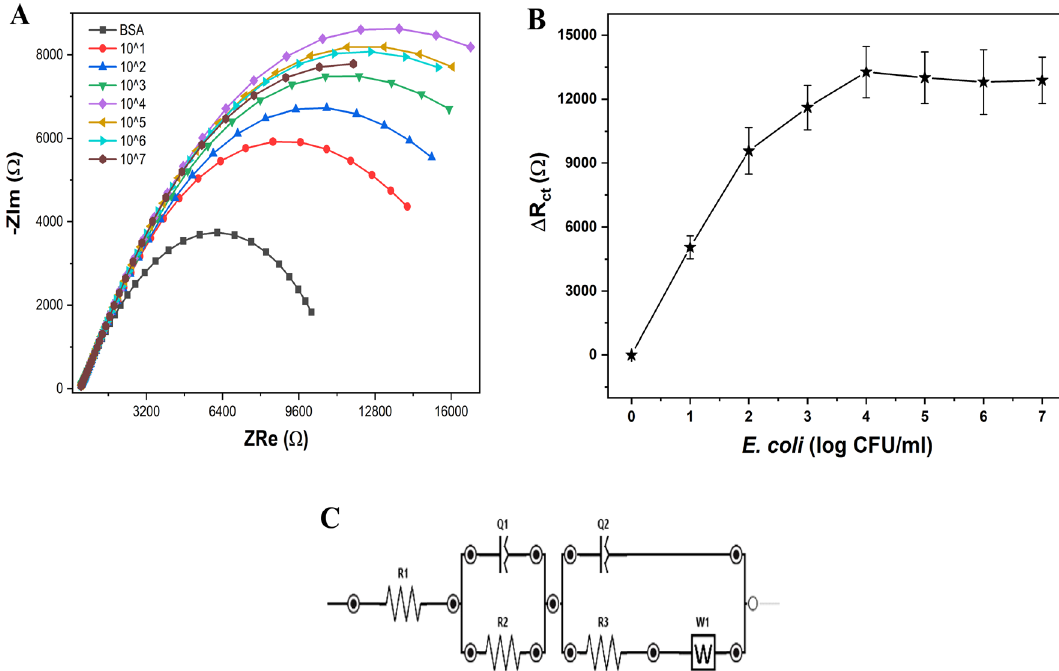
Figure 4. ( A )-Nyquist plots of the impedimetric calibration curve resulted from the successful binding events taking place at the surface of the phage-based biosensor. Measurements were conducted at different counts of the E. coli O157:H7 within the concentration range of 10 1 to 10 7 CFU/ml. ( B ) The relationship